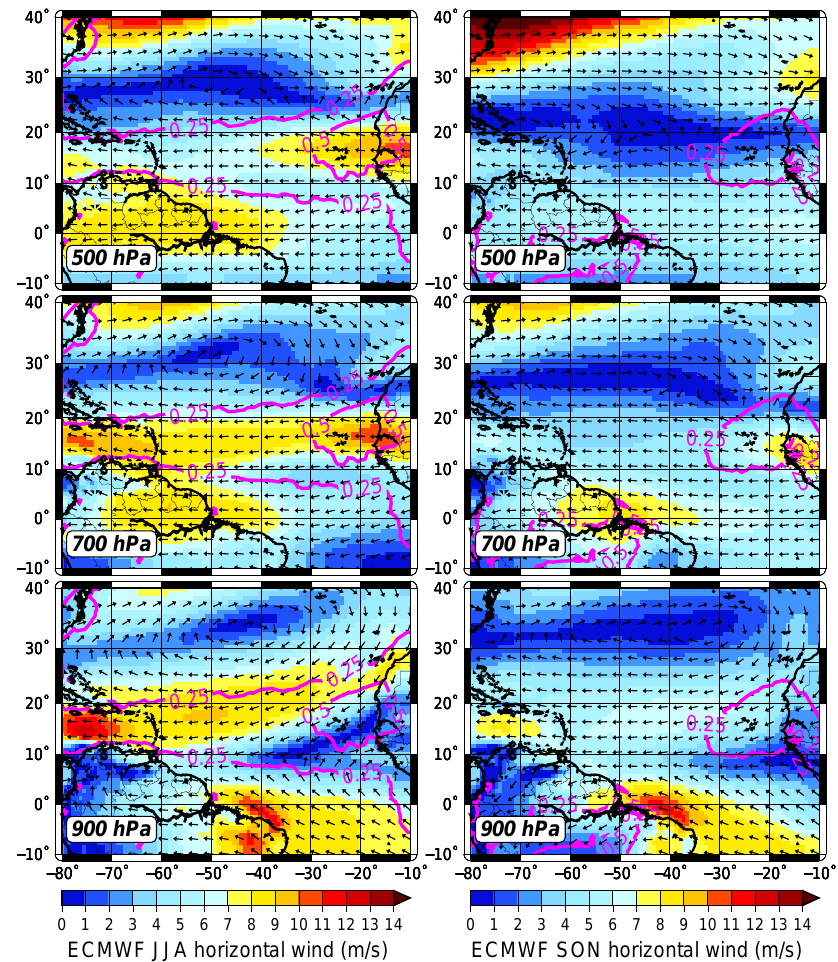
Fig. 9. Same as Fig. 8 but for summer (JJA – left) and fall (SON – right) seasons. with altitude of the direction change can explain the ellipsoid shape on the northern part of the SAL seen in Fig. 3